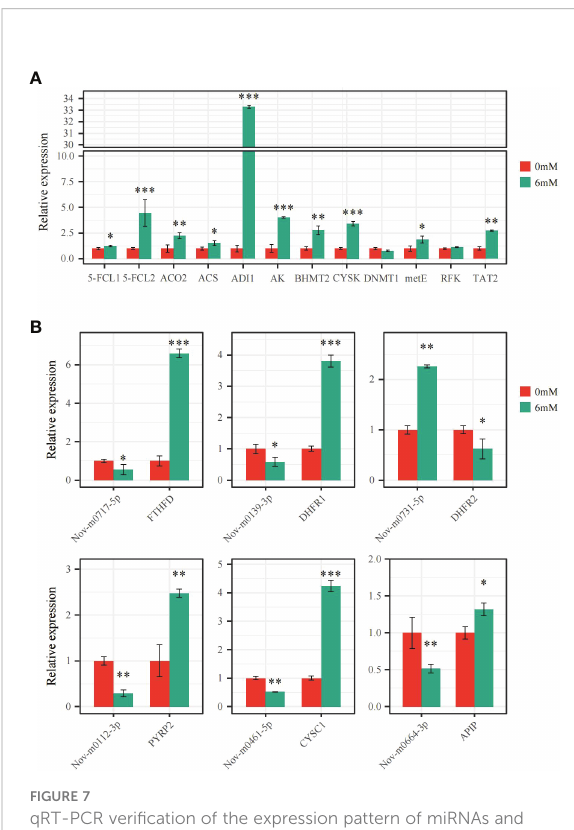
FIGURE 7 qRT-PCR veri fi cation of the expression pattern of miRNAs and DEGs (A) the expression level of DEGs related to folate and Met metabolism pathway were analyzed by qRT-PCR; (B) the expression level of miRNAs and targeted FTHFD, DHFR1/2, PYRP2, CYSC1 and APIP genes were analyzed by qRT-PCR. “ * ” indicates signi fi cant difference (p < 0.05), “ ** ” and “ *** ” indicate extremely signi fi cant differences (p<0.01 and